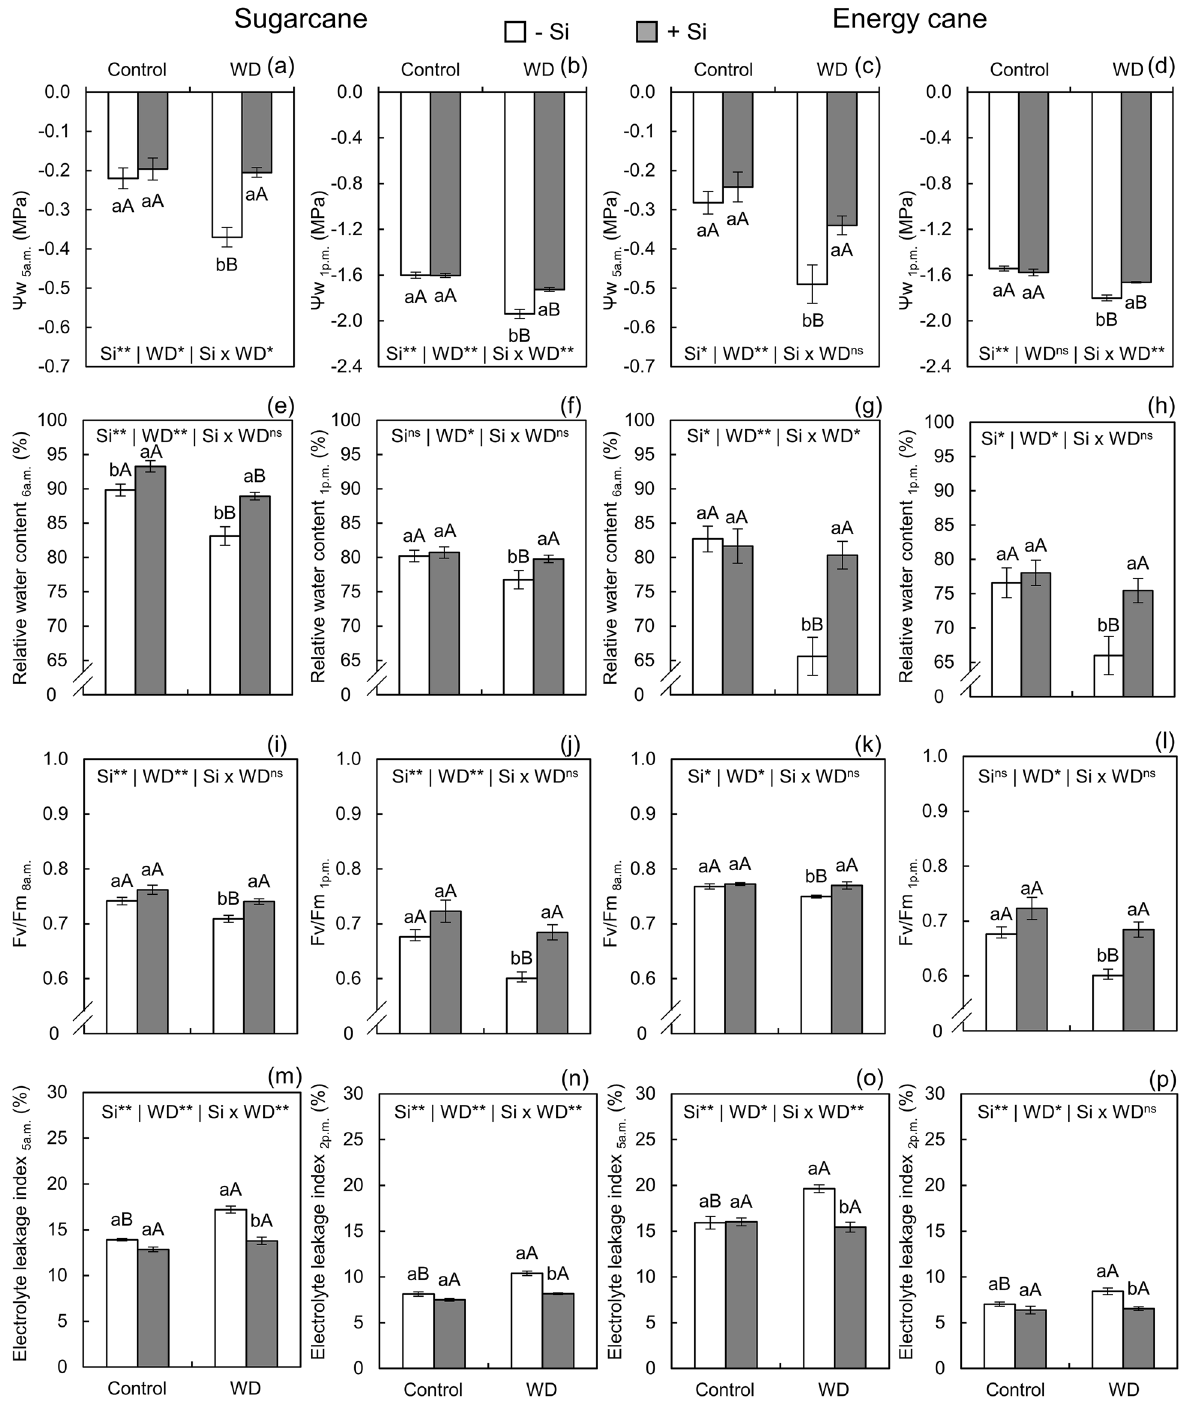
Figure 2. Leaf water potential (Ψw), relative water content, quantum efficiency of photosystem II (Fv/Fm), and electrolyte leakage index in sugarcane ( a , b , e , f , i , j , m , n ) and energy cane ( c , d , g , h , k , l , o , p ) in the absence of Si (-Si) and with Si applied via fertigation associated with foliar spraying (+ Si) under adequate water regime (control) and severe water deficit (WD) for a period of 7 to 160 days after transplanting. ** and * : significant at 1 and 5% probability, respectively; and ns : not significant by the F-test. Different lowercase letters indicate differences in relation to Si in the same water regime; different capital letters indicate differences in relation to the water regime in the same conditions of Si supply, both by the Tukey test. Bars represent the standard error of the mean; n =